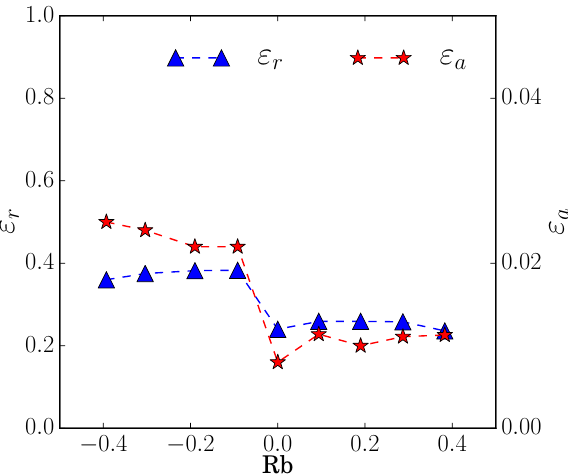
Figure 18. Canyon-averaged relative error in u x versus